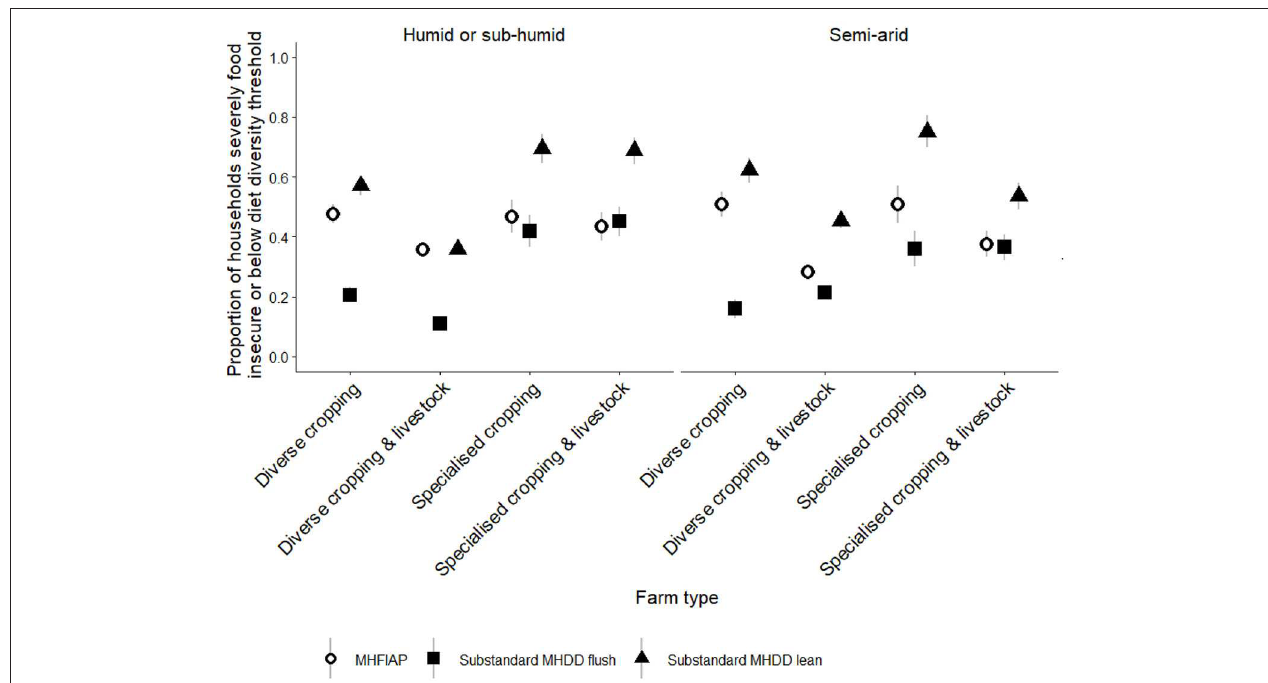
FIGURE 4 | Proportion of households ( n = 6,353 weighted by population) with insecure access to food (MHFIAP) or substandard household diet diversity (MHDD) by farm type and agro-ecological zone. 95% confidence intervals are represented by gray vertical